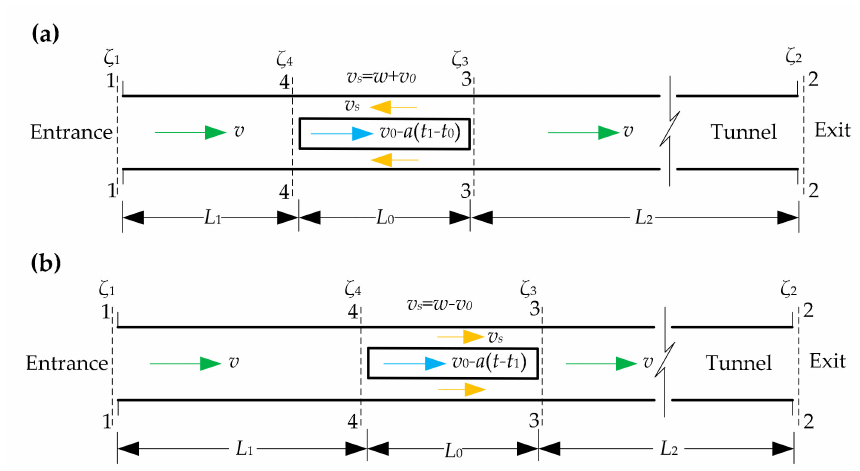
Figure 4. Schematic of uniformly decelerated motion phase. ( a ) Prophase. ( b ) Late